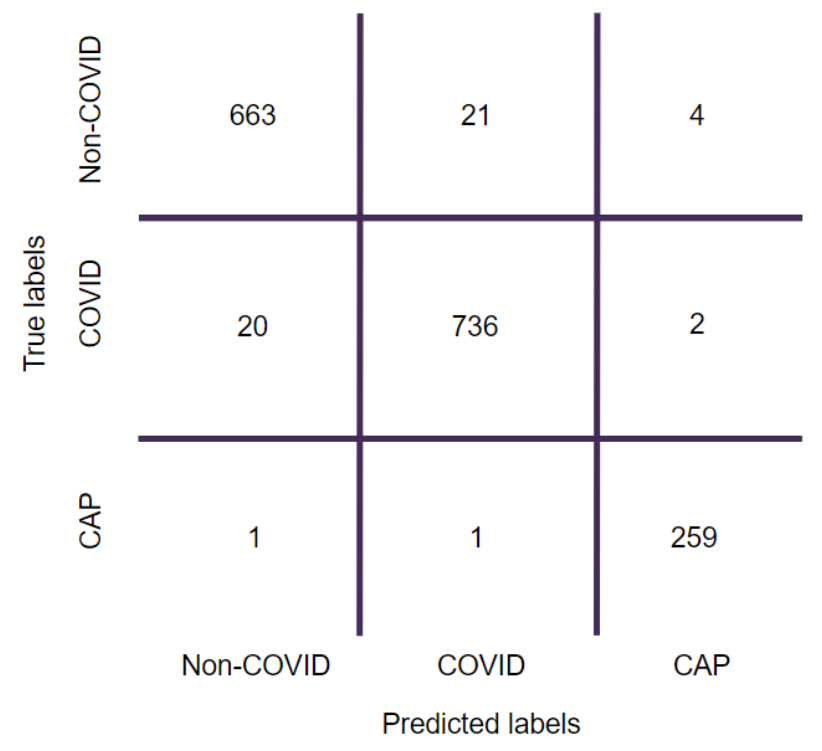
Figure 30. Confusion matrix generated for the CNN with LSTM and attention mechanism-based model for the clustering-based approach.